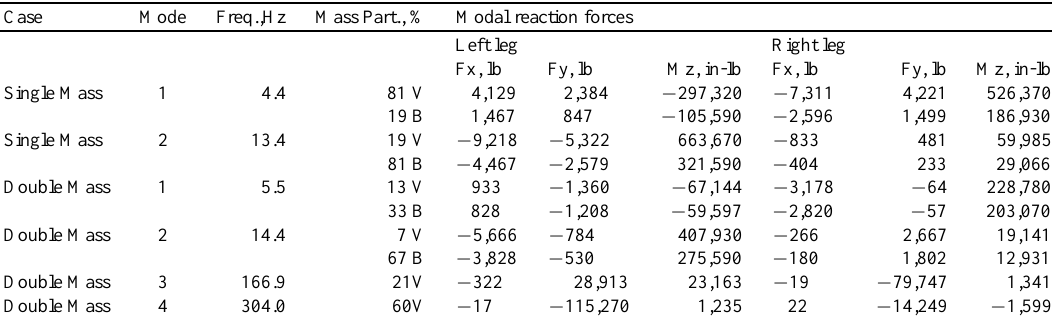
Fig. 11. Mode shapes for symmetric structure and symmetric mass. Table 4 Shock analysis results for rod cases; Asymmetric